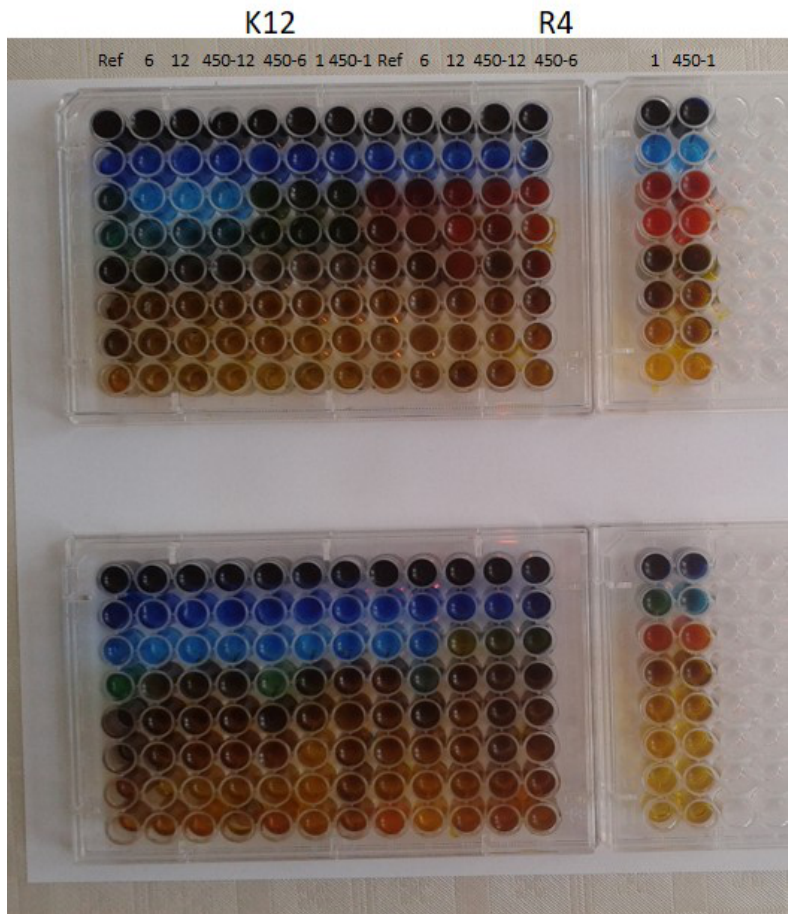
Figure 3. Examples of MIC and MBC on microplates with different concentrations of studied compounds ( µ g/mL − 1 ). The numbers correspond to sample names: 1 denotes SilS-COOAg1, 6 cor- responds to SilS-COOAg6, and 12 to SilS-COOAg 12. RefSilS was marked as Ref. All experiments were performed in duplicate. Resazurin was added as an indicator of microbial growth with K12, R4 strains with tested Ag